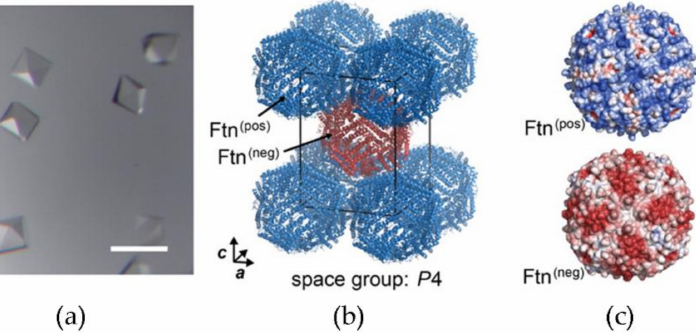
Figure 7. ( a ) Optical micrograph of crystals of engineered ferritin proteins to display a cationic (Ftn(pos)) or anionic (Ftn(neg)) surface, scale bar 200 µ m. ( b ) Molecular structure of binary crystals. One unit cell of the tetragonal lattice is shown, protein backbone depicted in cartoon representation. ( c ) Electrostatic potential (red, − 5 kT/e; blue, +5 kT/e) of Ftn(pos) and Ftn(neg), viewed along the 4-fold axis. Adapted with permission from [69]. Copyright © 2021, American Chemical